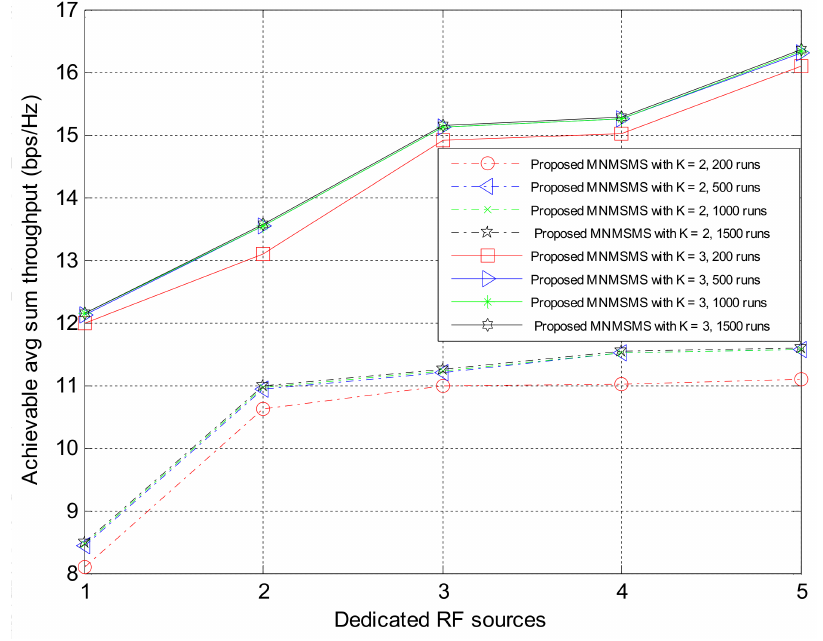
Figure 4. The impact of run time on the average system-achievable